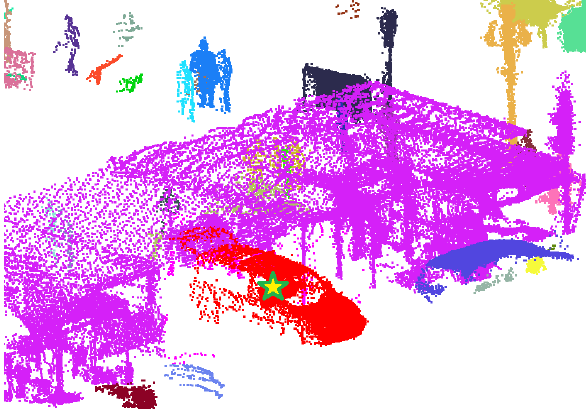
Figure 1: Example of a car within a complex urban scene, cor- rectly detected by our method (colored red)